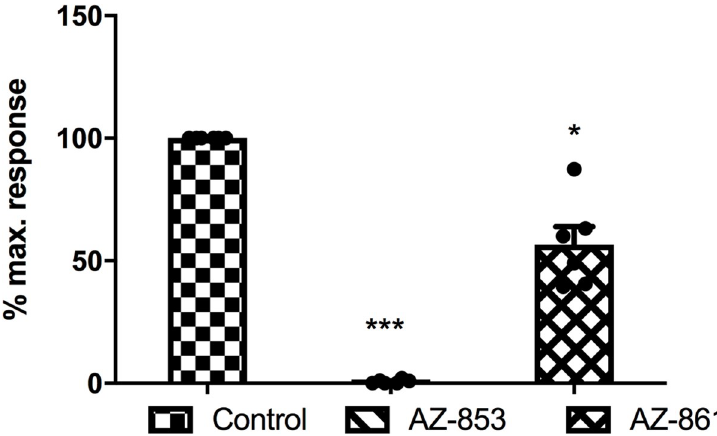
Fig 8. Effects of AZ-853 and AZ-861 on the blood pressure response to methoxamine (150 μ g/kg). All values represent the mean ± SEM, n = 6. Statistical analysis was performed using Student’s t-test; � p < 0.05, ��� p < 0.001 vs. control